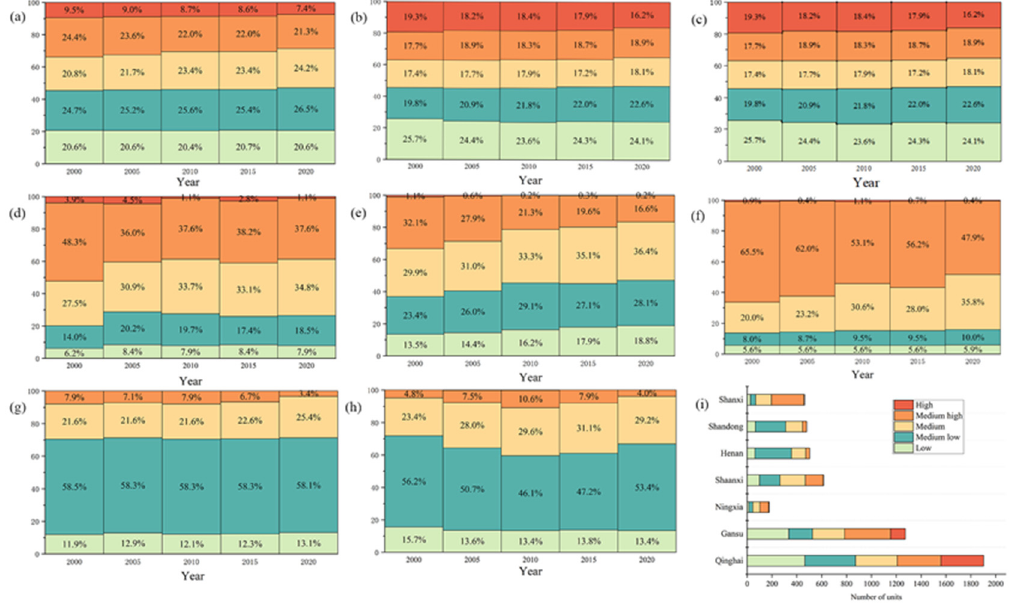
Figure 5. ( a – h ) Risk structure for the five time periods. ( i ) The average number of units at different risk levels. Note: YREEB ( a ), Qinghai ( b ), Gansu ( c ), Ningxia ( d ), Shaanxi ( e ), Shanxi ( f ), Henan ( g ), Shandong ( h ).